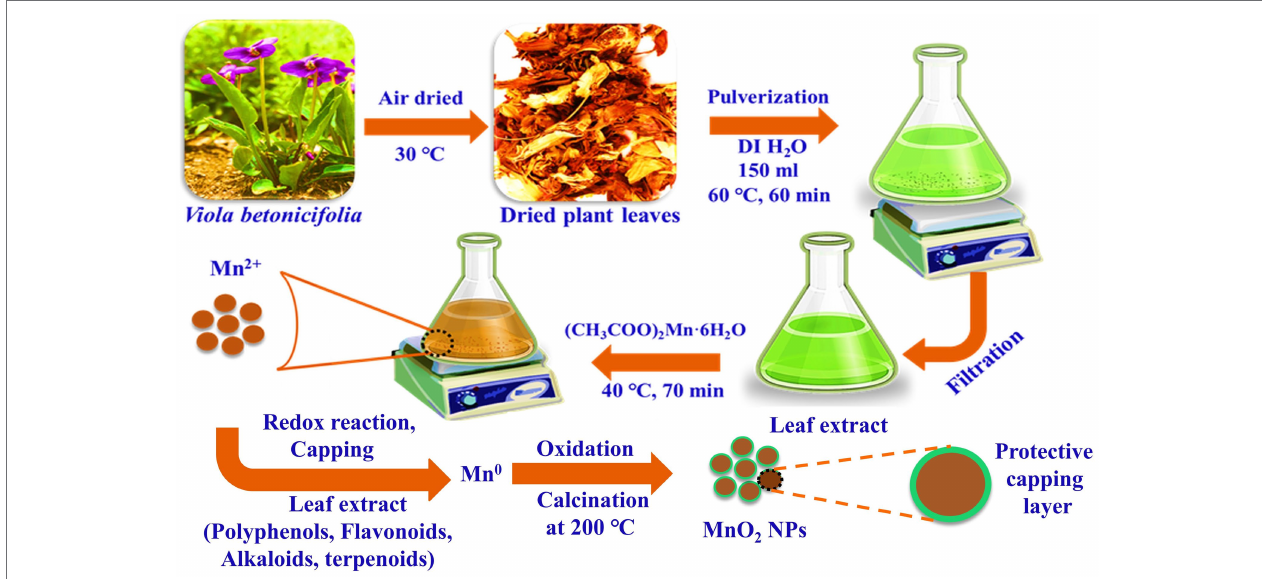
FIGURE 1 | Schematic demonstration and possible synthesis mechanism for the green synthesized VBLE-MnO 2 NPs with the leaves extract of Viola betonicifolia